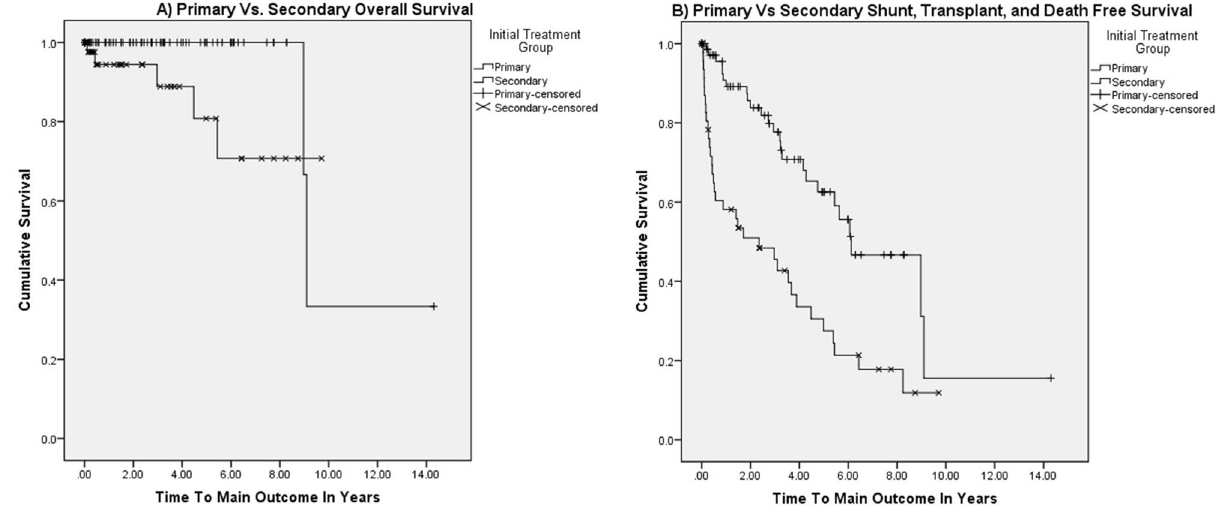
Figure 1. ( A ) Kaplan–Meier Overall Survival Curve for Primary and Secondary Endoscopic Prophylaxis (log- rank p = 0.023). ( B ) Kaplan–Meier Survival Curve without portosystemic shunt or liver transplant for Primary and Secondary Endoscopic Prophylaxis (log-rank p <